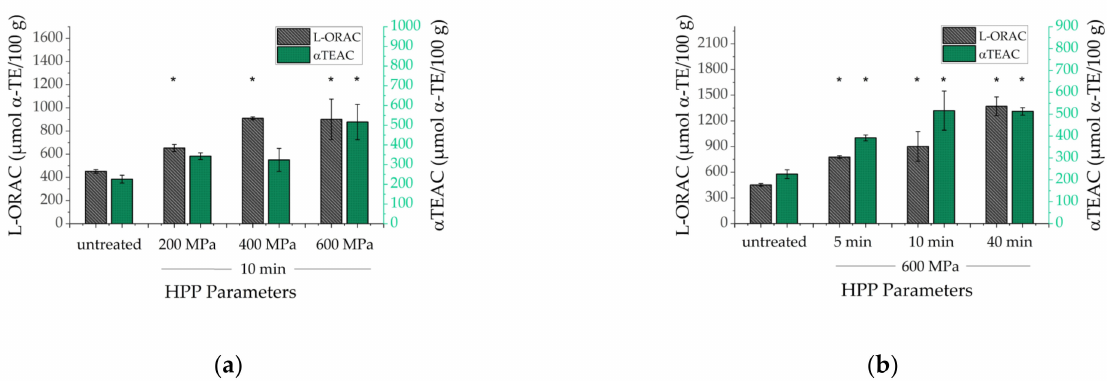
Figure 7. Comparison of the antioxidant capacity of untreated and HP-treated kale, using a fixed treatment period (10 min) and varying pressure rates up to 600 MPa ( a ) as well as a fixed pressure rate (600 MPa) with varying treatment periods up to 40 min ( b ). One-way ANOVA with Tukey-HSD post hoc test: asterisks in the same line indicate significant differences ( p < 0.05) between treated and untreated